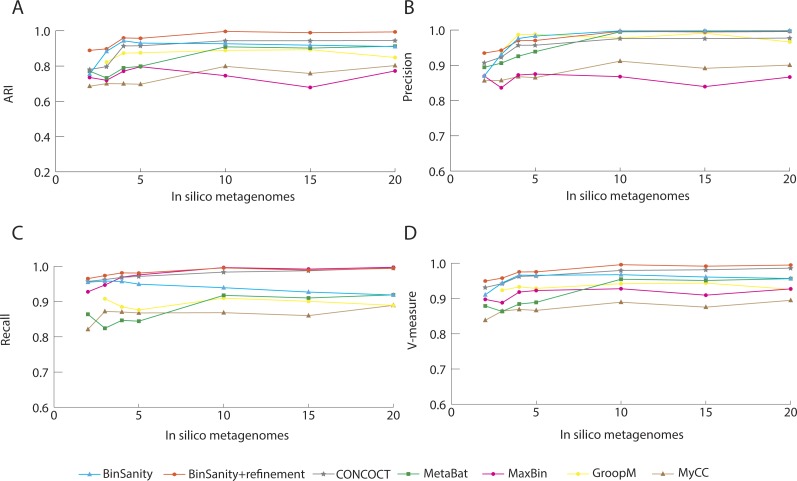
Statistical calculations (bin_evaluation.py) for Adjusted Rand Index (A), Precision (B), Recall (C), and V-Measure (D) for the strain-mixture.